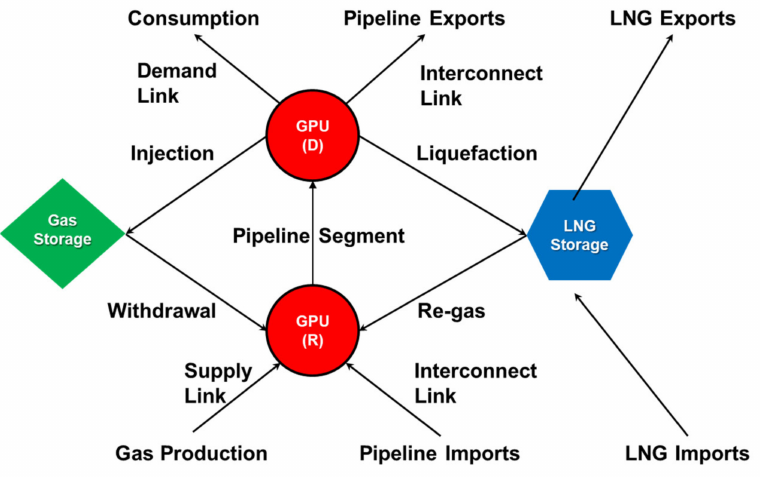
Figure 4. Definition of a geopolitical